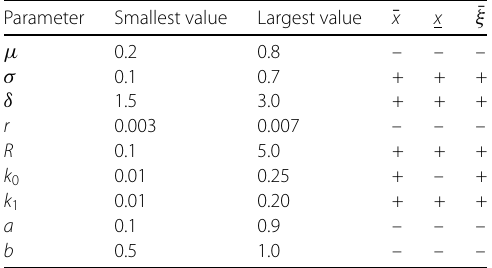
Table 2 Parameter dependence of the thresholds ¯ x , x = x ( ¯ x ), and the amount of harvesting In this table, the notations “+” and “–” mean means increase and decrease of ¯ x , x , or each parameter, respectively